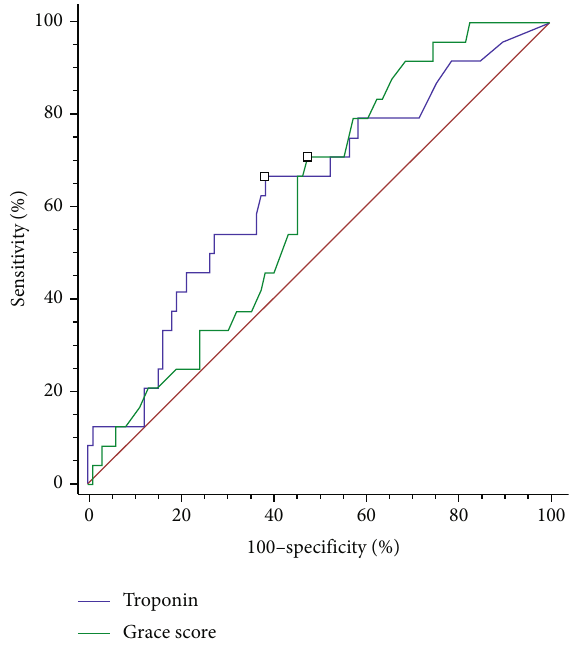
Figure 3: Comparison of the receiver-operating characteristic curves of troponin I and the Global Registry of Acute Coronary Events (GRACE) score for predicting 6-month mortality in patients with sepsis.